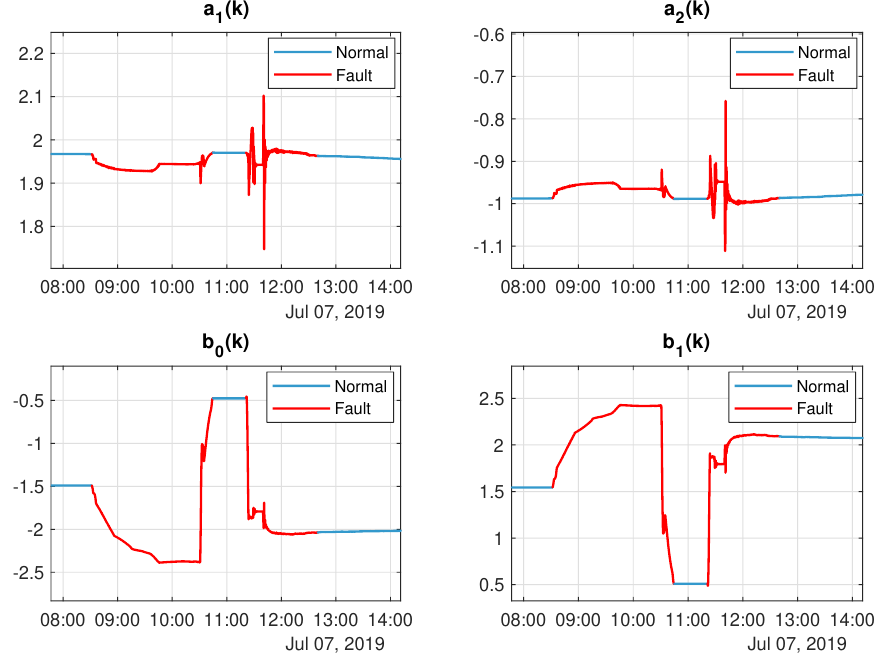
Figure 9. Model parameter evolution over time. The sample period employed was 1 s and the Figure 13: The proposed method consists in transmitting a frame using ⌈ α n cha ⌉ channel uses for the fi rst parameters considered are: θ = [ a 1 ( k ) a 2 ( k ) b 0 ( k ) b 1 ( k )] T . The fault instants are highlighted transmission attempt, with 0 < α ≤ 1 . In the event of a decoding error, incremental redundancy is transmitted 1 − α n cha ⌋ channel uses. making use of the rest of the available ⌊ ( )